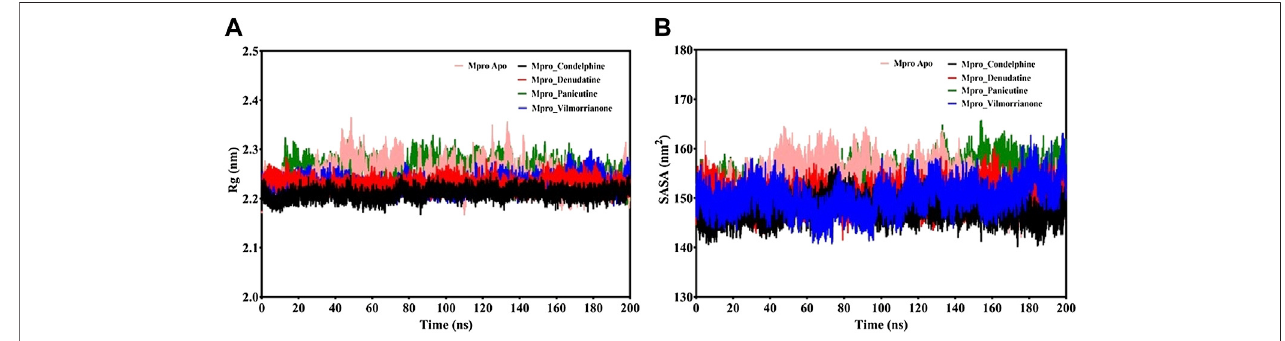
FIGURE 6 | (A) Rg plot of docking complexes and (B) SASA plot of docking complexes [control (pink), M pro – condelphine (black), M pro – denudatine (red), M pro – panicutine (green), and M pro – vilmorrianone